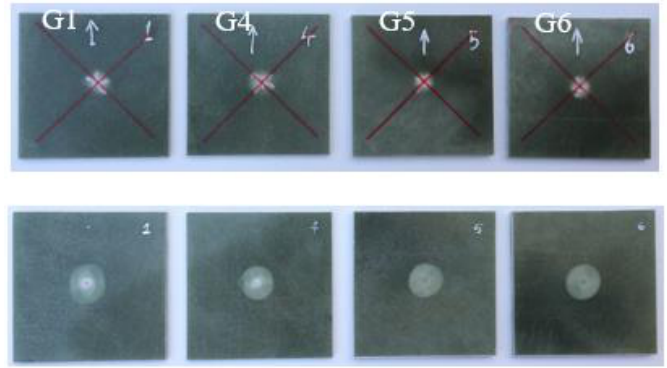
Figure 8. Glass-fiber epoxy plates, (Top: front side, bottom: backside).